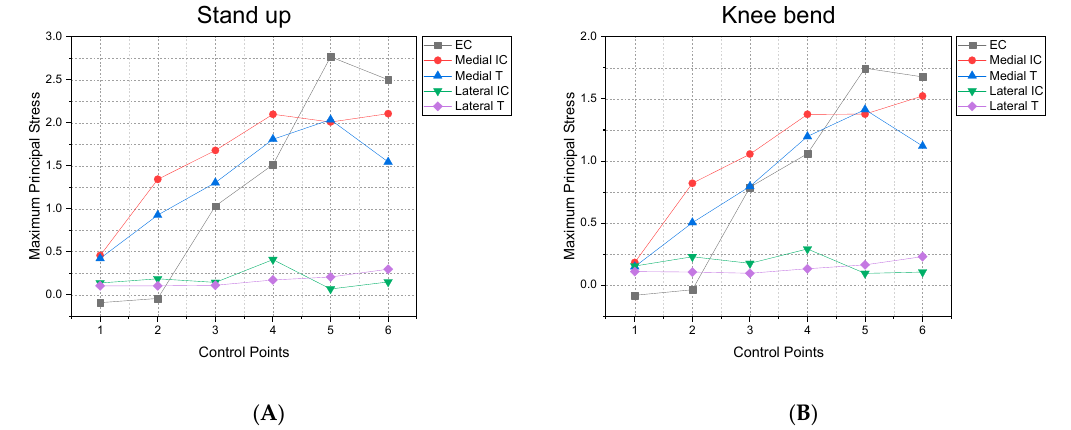
Figure 7. Maximum principal stresses occurring at the control points when applying ( A ) standing up and ( B ) knee bending loads.